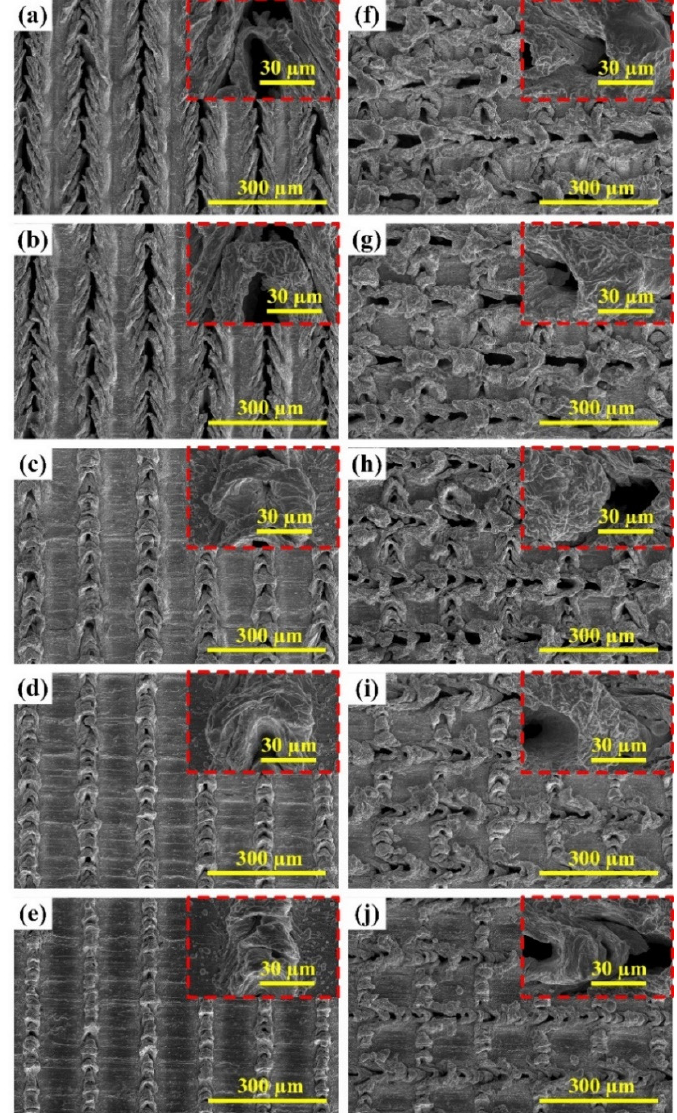
Figure 4. SEM micrographs of the laser textured BMG surfaces using different powers: ( a – e ) unidirectional surface patterns with the laser powers of 15.0 W, 13.5 W, 12.0 W, 10.5 W, and 9.0 W; ( f – j ) cross-hatch surface patterns with the laser powers of 15.0 W, 13.5 W, 12.0 W, 10.5 W, and 9.0 W.